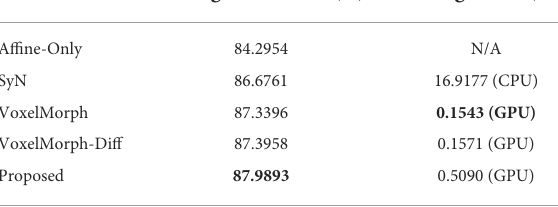
TABLE 1 The average dice scores (%) and average registration times (sec) of all competing methods on the mouse brain test set.